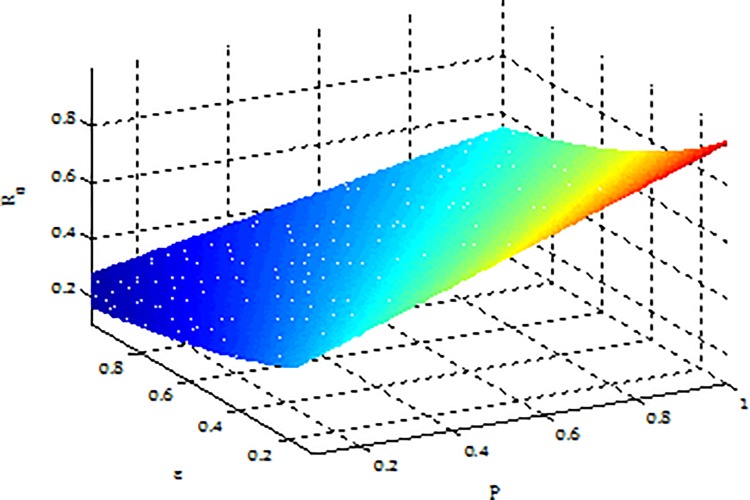
An illustration of effect of p andεon R0.